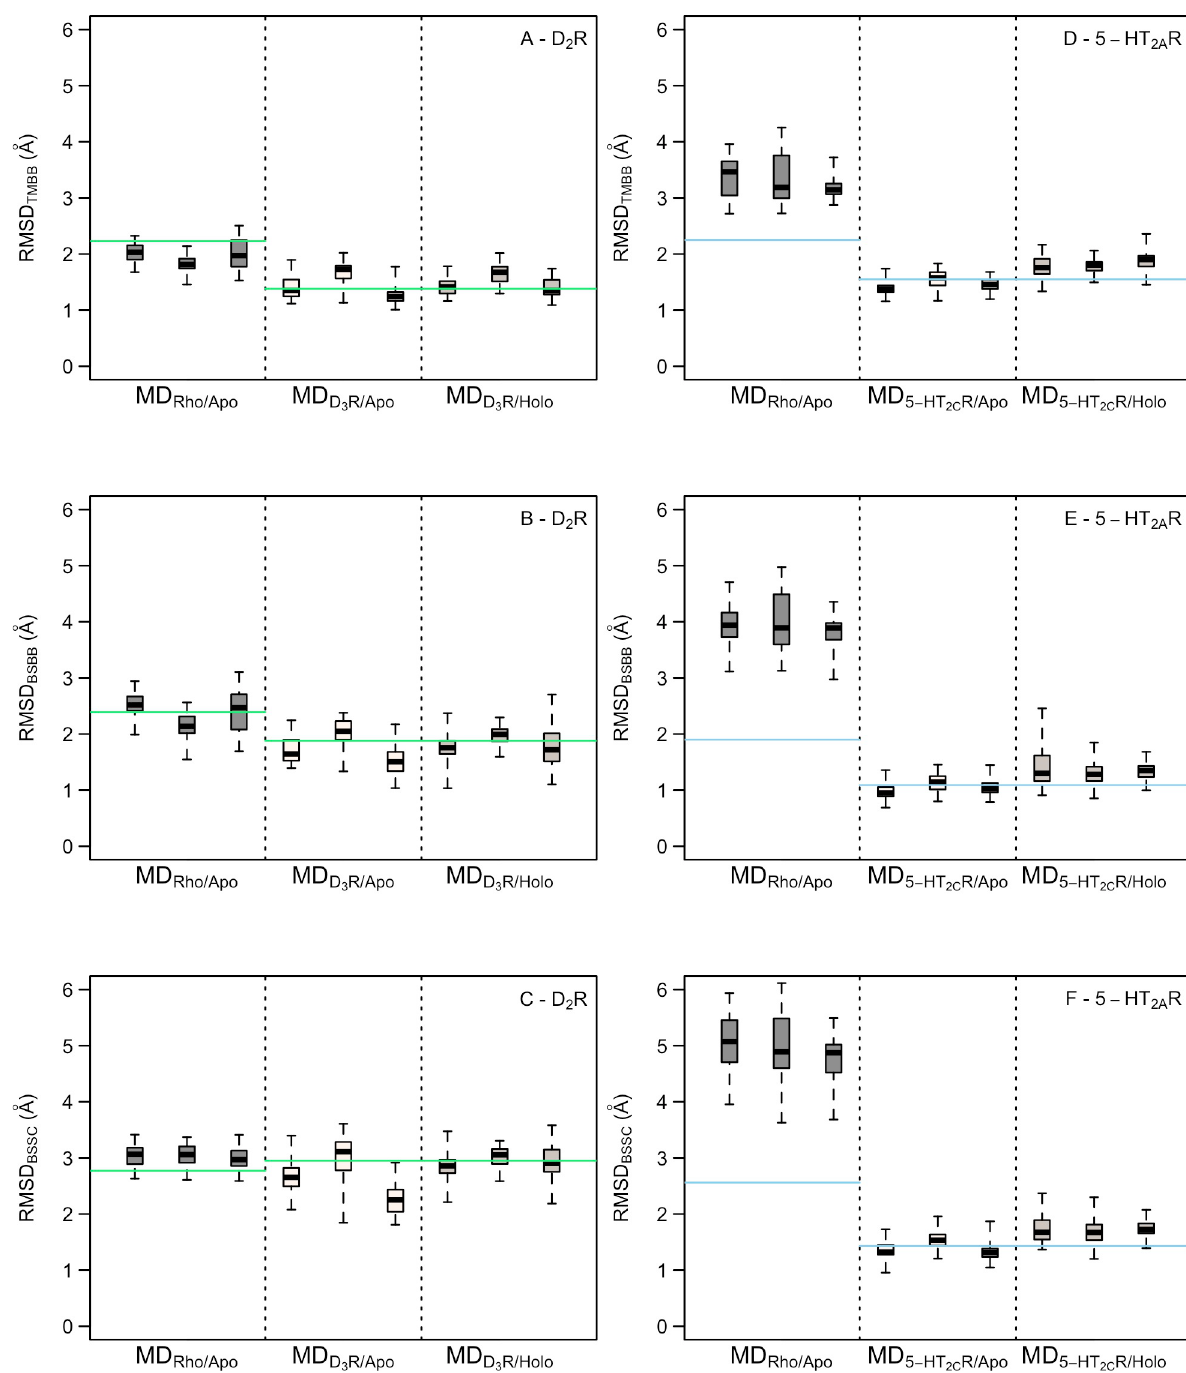
Fig 7. Structural accuracy of MD simulation snapshots. RMSD distribution of the TM backbone, BS backbone, and BS side chains of MD snapshots to the crystal structure for the D 2 R (A-C) and 5-HT 2A R (D-F). Distributions of RMSD values for the three sets of snapshots based on the Rho-based models (MD Rho/Apo ) and homology models based on the most closely related template in apo (MD Template/Apo ) and holo forms (MD Template/Holo ) are shown using a boxplot representation. The box represents the 50th percentile of the data and the black band shows the median value. The lowest and highest RMSD values are represented by the whiskers. The horizontal lines show the RMSD values of the homology model used as starting